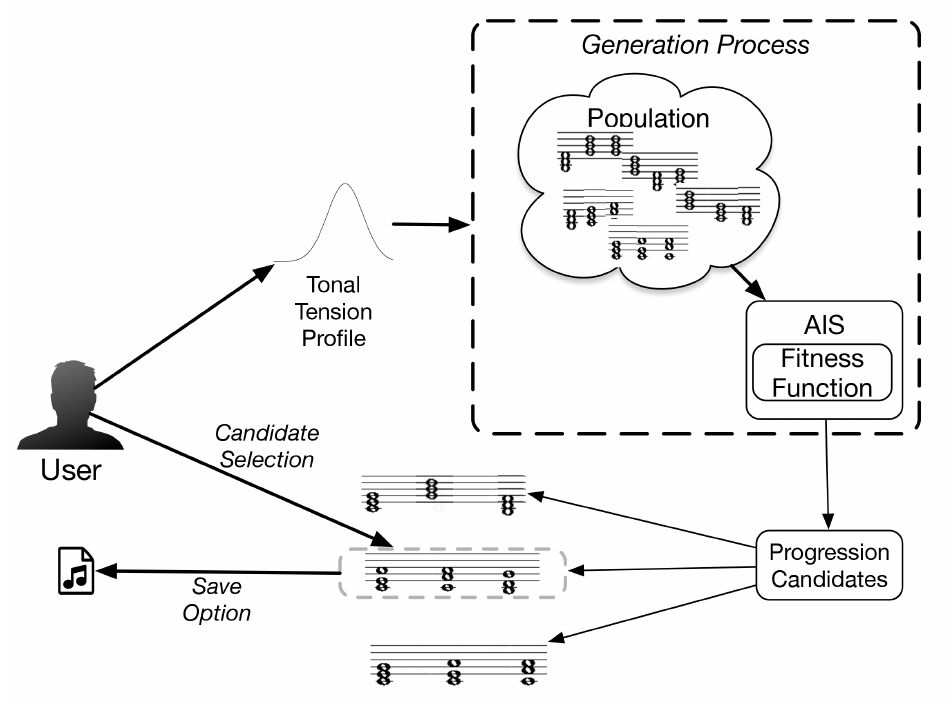
Figure 2. Overview of the approach proposed in this work. We did not draw the trees associated to each chord progression for more